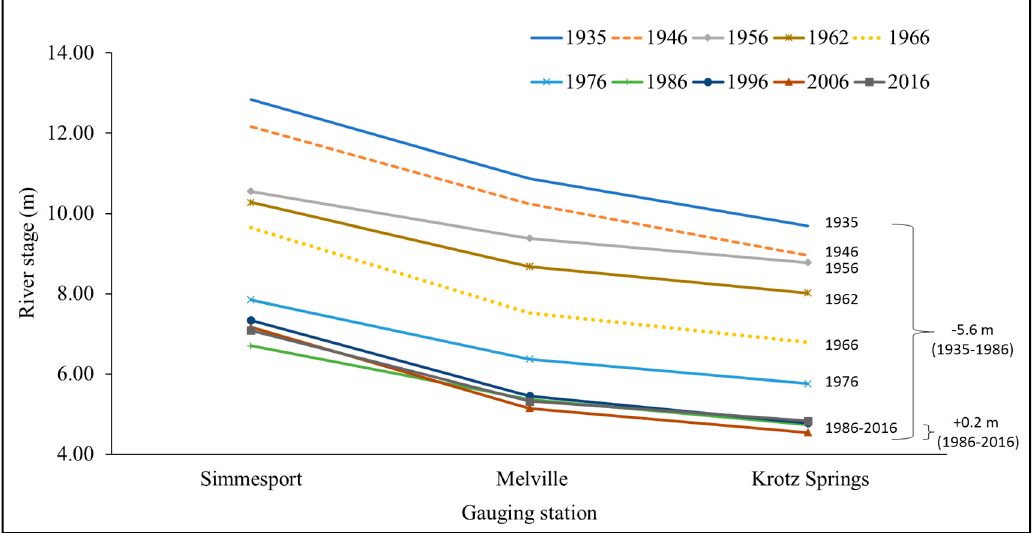
Figure 9. River stages at Simmesport, Melville, and Krotz Springs along the uppermost Atchafalaya River during high flows (i.e., 8000 ± 100 m 3 s − 1 ) between 1935 and 2016.